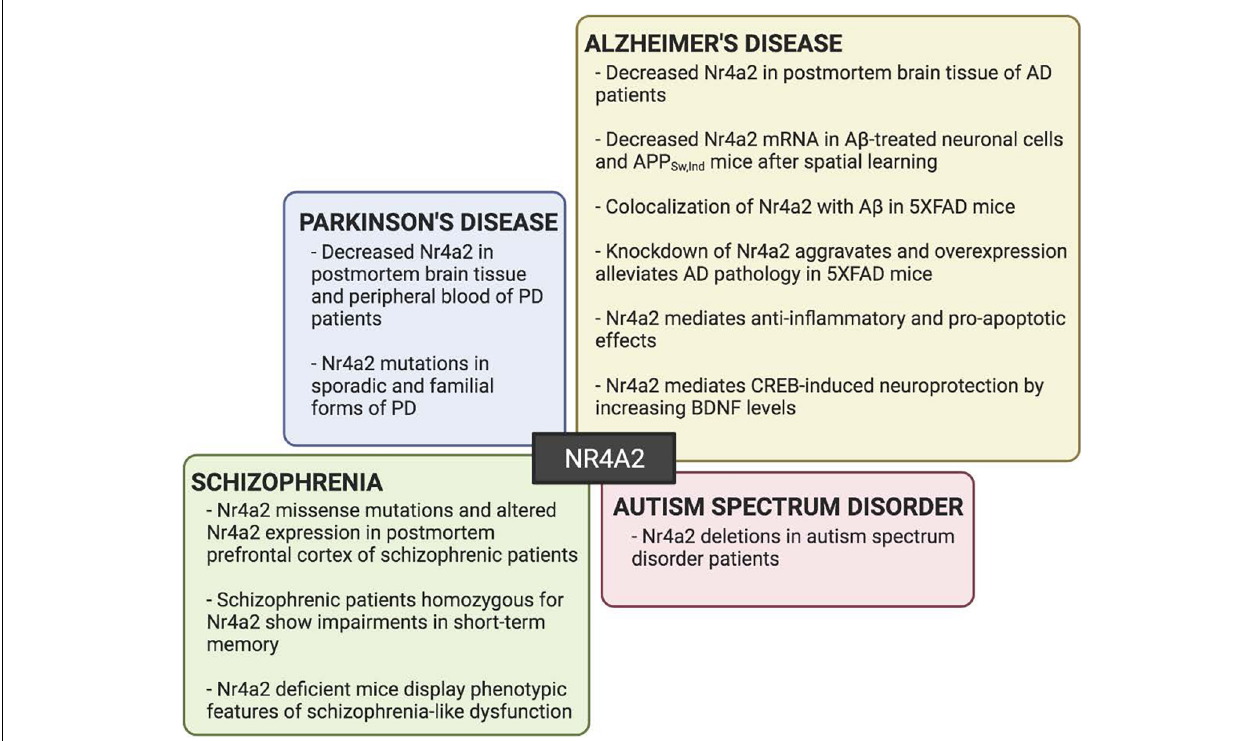
FIGURE 3 | Nr4a2 involvement in different cognitive and neuropsychiatric brain disorders. Schematic representation of Nr4a2 functions and/or alterations in neurodegenerative disorders (Parkinson’s disease, Alzheimer’s disease), schizophrenia and autism spectrum